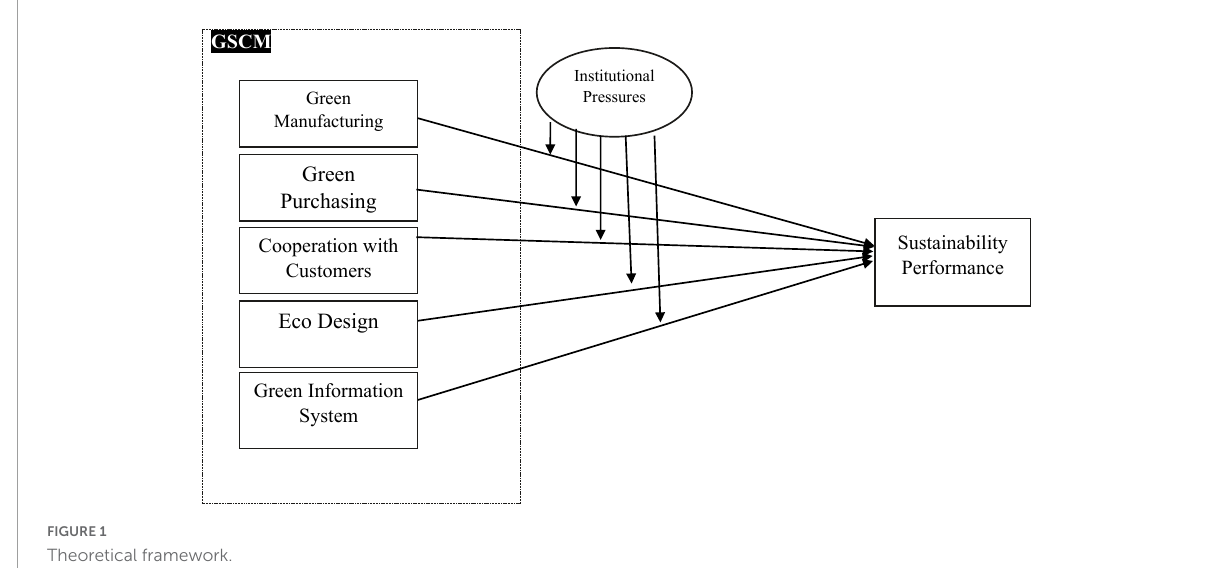
FIGURE1 Theoretical framework.